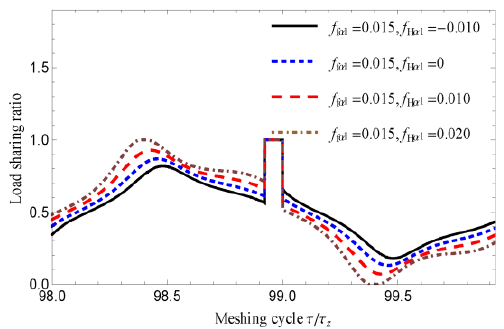
Figure 16. Dynamic mesh force of a single pair of teeth under different 𝑓 𝐻𝛼1 .